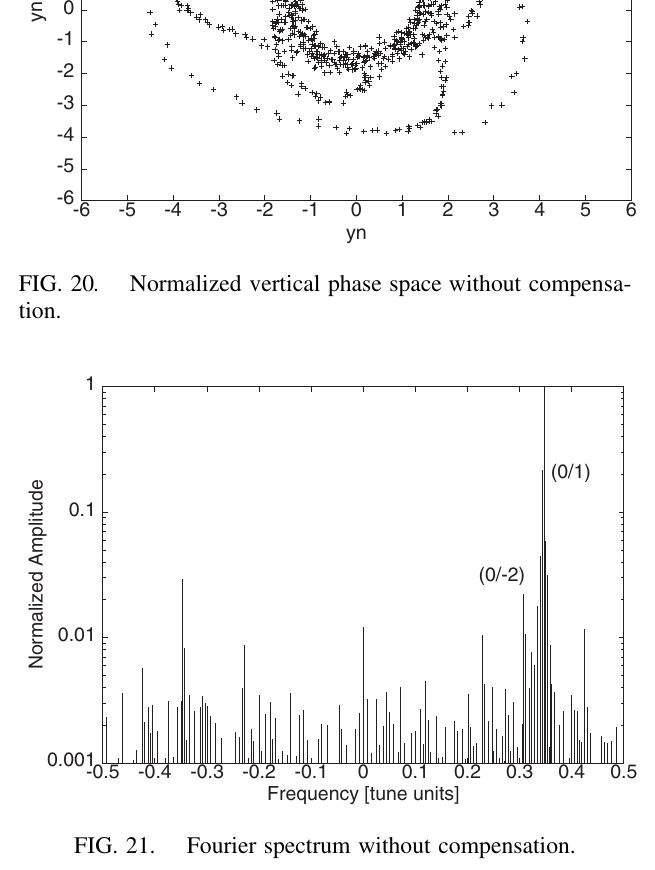
(i) Measurement of the bare machine excitation. —